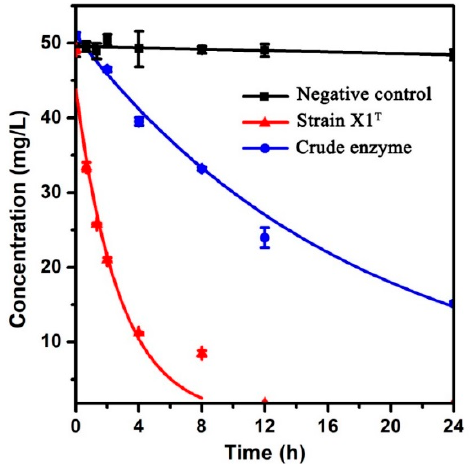
Figure 6. Degradation of 50 mg/L chlorpyrifos by strain X1T and crude enzyme.